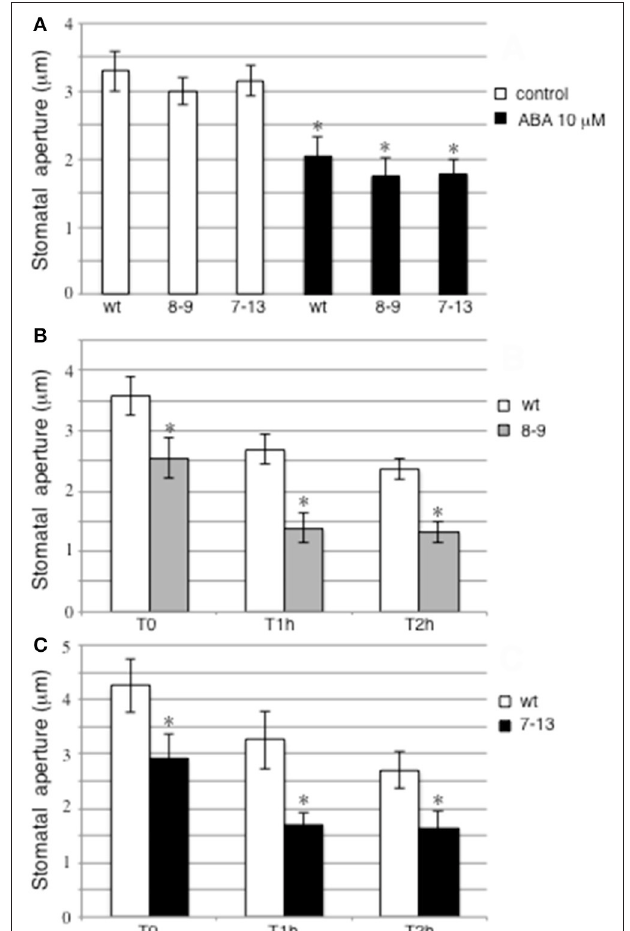
FIGURE 3 | Analysis of stomata movement in wild type and PII over-expressing transgenic lines. (A) Effect of 10 µ M ABA on stomata closure. Epidermal strips from detached leaves were exposed to light for 3h and then treated with (black bars) and without ABA (white bars) for an additional hour. Asterisks indicate significant differences between ABA-treated and un-treated plants ( p < 0.0001; VassarStats analysis of variance program). (B,C) Stomata aperture in detached leaves from stems cutting isolated at the 6th hour of the daily light period and sealed at the bases to avoid water loss by gravity at T0, 1, and 2h after cutting. Wild type and transgenic lines are indicated. Asterisks indicate significant differences between transgenic and wild type plants ( p < 0.0001; VassarStats analysis of variance program). Bars represent the average and SE for three independent experiments. For each treatment, at least 60 stomatal apertures were measured and data presented are the means of at least 3 independent experiments (2 leaves per